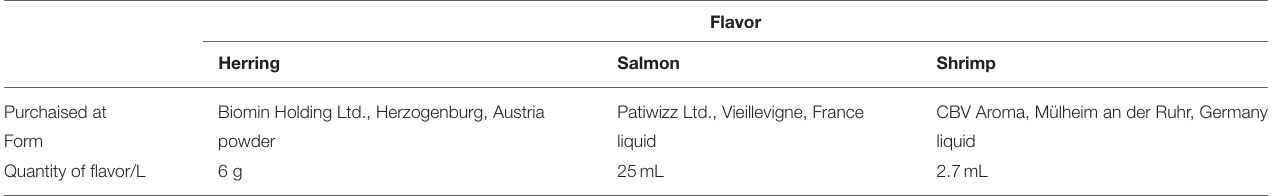
TABLE 2 | Flavors and concentrations used to produce ice cubes with fish and non-fish flavors.